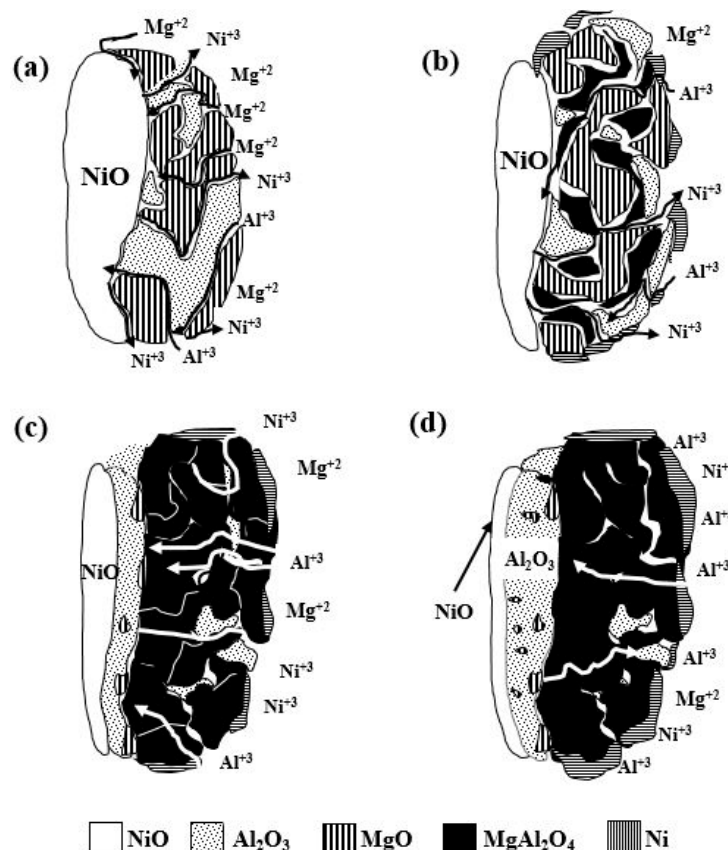
Figure 18. Scheme of the mechanism of reaction proposed for the permanent contact reaction between dissolved magnesium in molten aluminum and NiiO particles; ( a ) instantaneous formation of MgO and Al 2 O 3 , 10 min; ( b ) MgAl 2 O 4 formation, 40 min; ( c ) nickel diffusion to the molten alloy, 70 min; ( d ) and consolidation of the layers of reaction products consisting of MgAl 2 O 4 separated by layers of the Al 2 O 3 phase, 90 min.